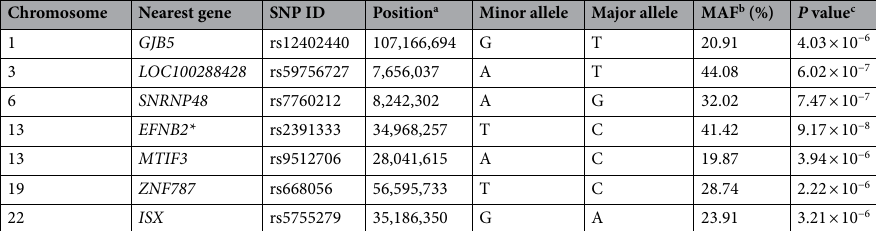
Table 2. Interactions between individual single nucleotide polymorphisms (SNPs) and 8 environmental factors. a Chromosomal positions are based on the 1000 Genomes Project’s haplotype phase 1 in NCBI build 37 (hg19). b MAF, minor allele frequency. c The P value for the effects of interaction between genotypes and environmental factors on BMI was assessed by using a Struct-LMM with adjustment for age, sex, and recruitment area. The nearest gene to which the SNP is